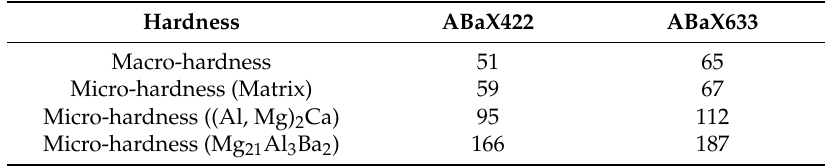
Table 2. Macro and micro-hardness (HV) values for ABaX422 and ABaX633 alloys.